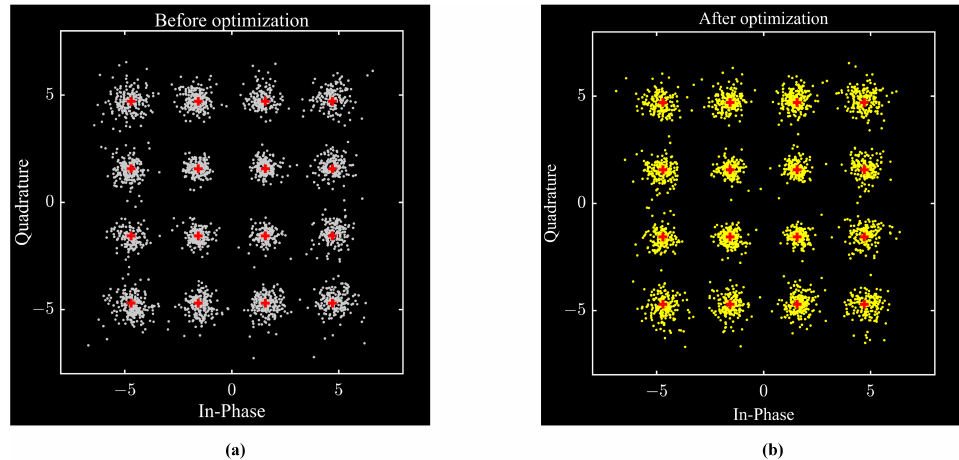
Figure 12. Echo constellation diagrams before and after PMEPR optimization. ( a ) Before. ( b )